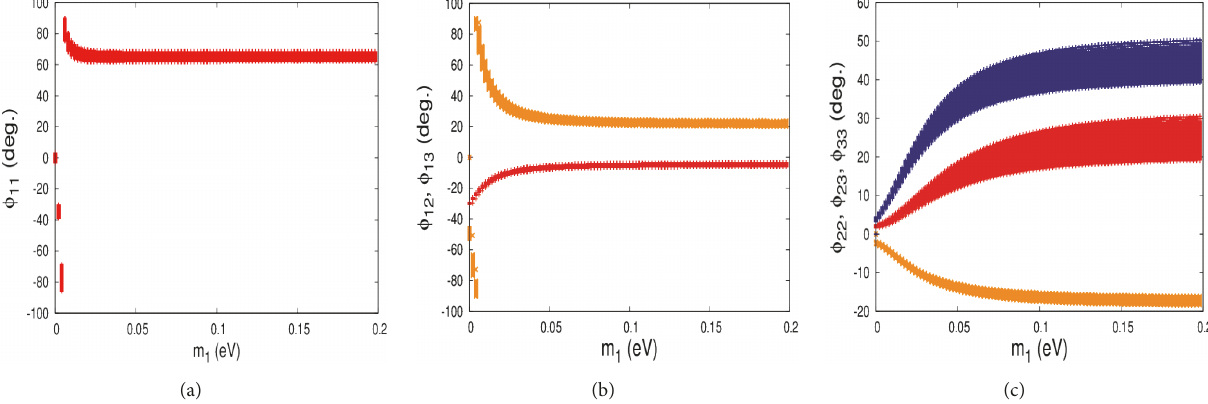
Figure 4: Determination of phases of 𝑌 matrix elements as a function of lightest neutrino mass eigenvalues 𝑚 1 within 1𝜎 allowed uncertainty of oscillation data. Phase angles used are the same as in Figure 2. In (a) red region denotes values of 𝜙 11 . In (b) red and yellow regions denote allowed values 𝜙 12 and 𝜙 13 , respectively. In (c) red, yellow, and blue patches give allowed values of 𝜙 22 ,𝜙 23 , and 𝜙 33 ,